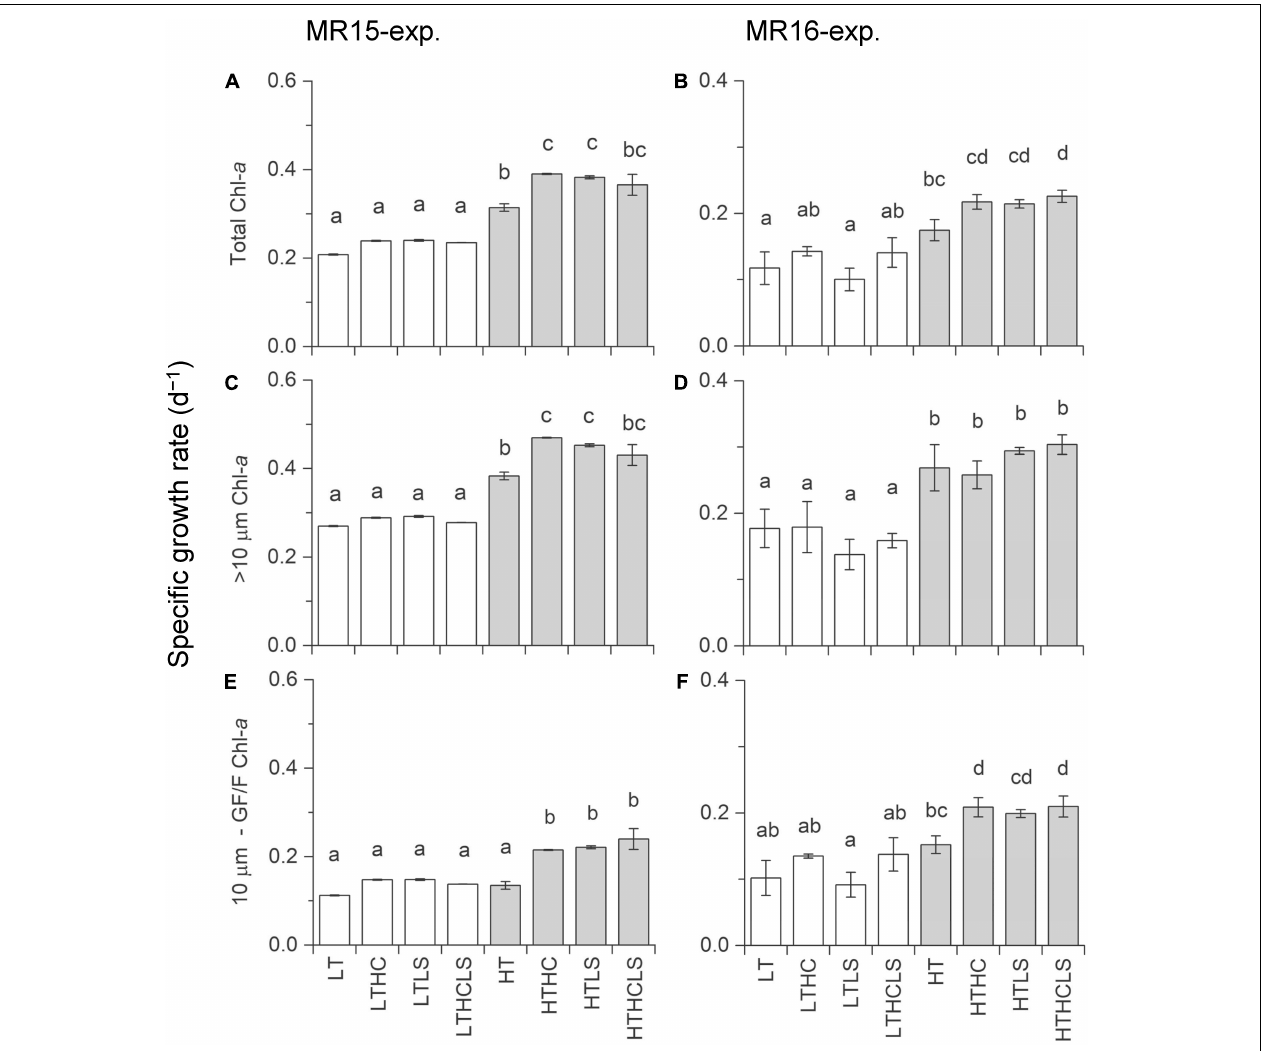
FIGURE 2 | Specific growth rates based on chlorophyll- a concentrations during the exponential growth phase. Left and right panels represent the MR15-exp. and the MR16-exp., respectively. (A,B) total chl- a , (C,D) > 10 µ m size fraction, and (E,F) < 10 µ m sized fraction. Letters above the bars represent statistical results of groups according to the Tukey–Kramer